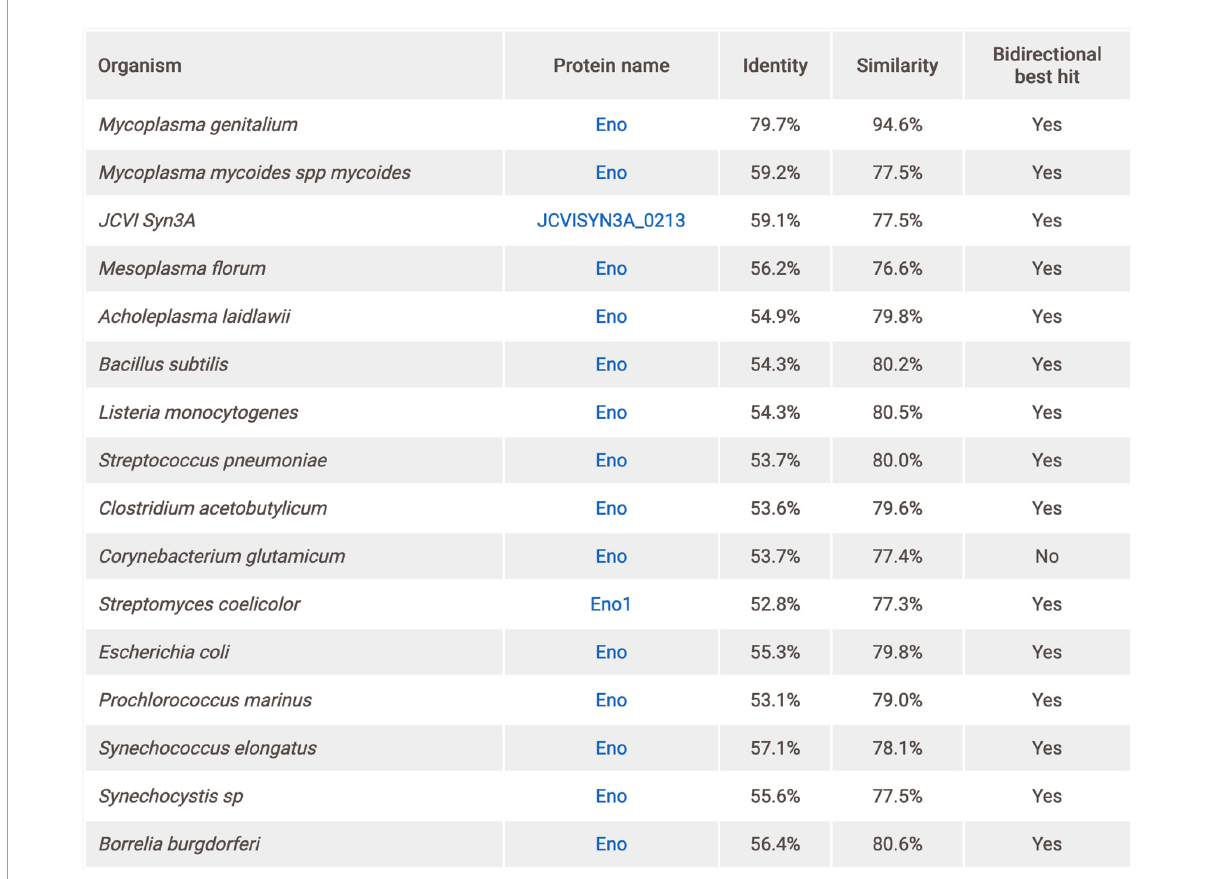
FIGURE7 Protein homology table for Eno. Best BLAST hits for 16 representative related organisms are featured, and scores on identity and similarity are provided.